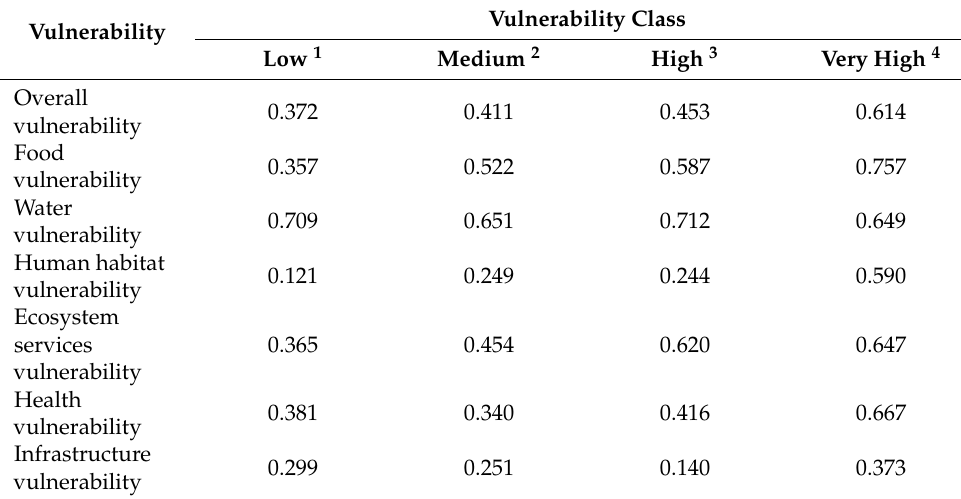
Table 2. Vulnerability classes by vulnerability